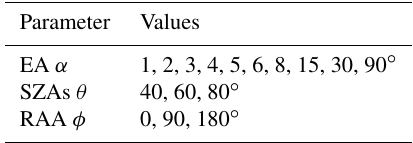
Table 4. Viewing geometry for the model calculations. SCDs are simulated for each combination of EA, SZAs, and